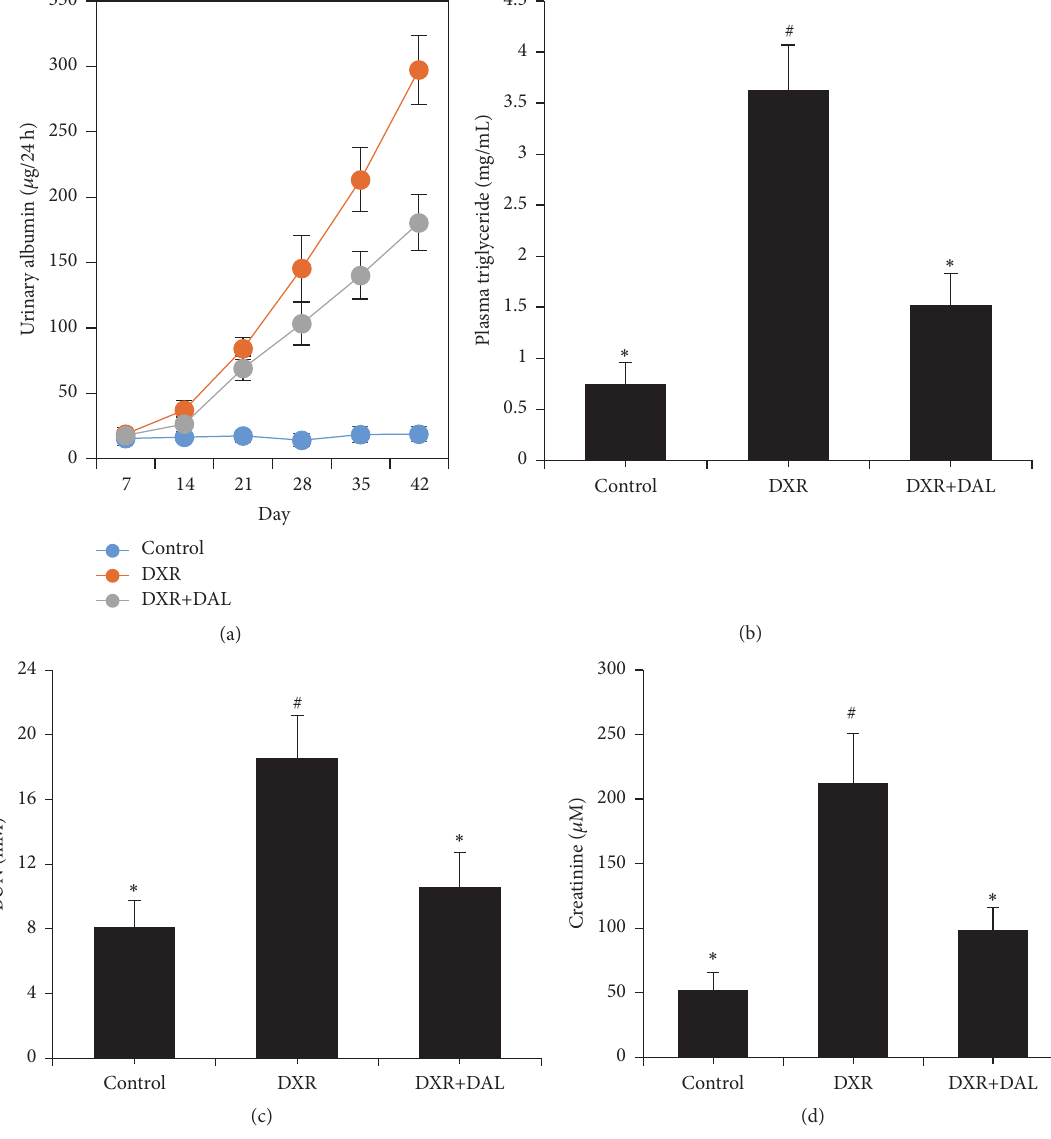
Figure 1: Kidney injury at 5 weeks after DXR injection in different groups of mice as indicated. (a) Effect of DAL on albuminuria against DXR- induced nephrotoxicity; (b) effect of DAL on hyperlipidemia against DXR-induced nephrotoxicity; (c) effect of DAL on blood urea nitrogen (BUN) against DXR-induced nephrotoxicity; (d) effect of DAL on serum creatinine against DXR-induced nephrotoxicity. The control and DAL treatment groups are compared with the DXR group. Values are statistically significant at ∗ 𝑝 < 0.05 ; the DXR group is compared with the control group. Values are statistically significant at # 𝑝 < 0.05